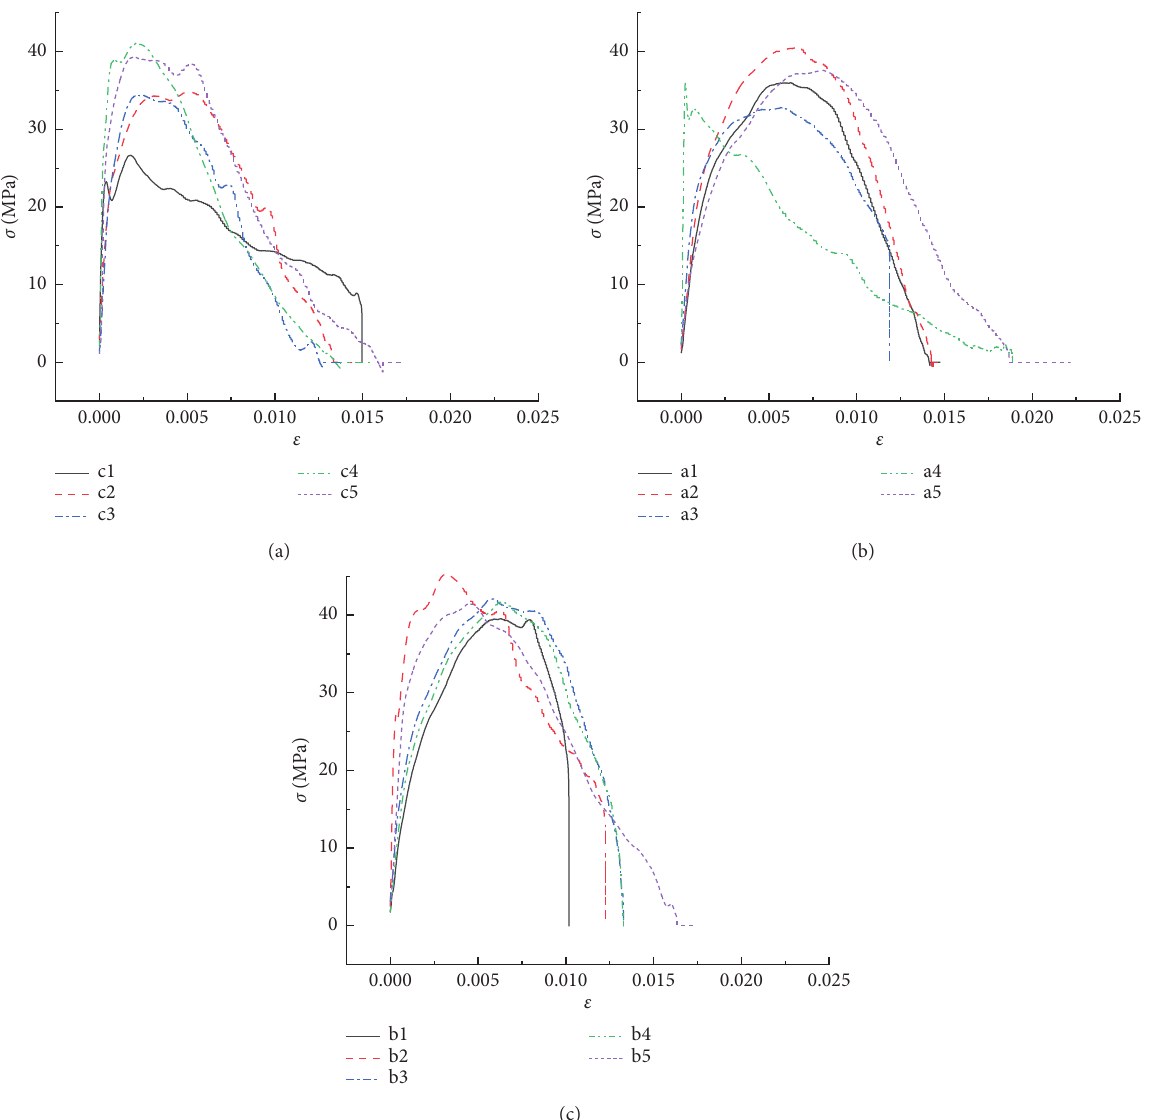
Figure 6: Stress-strain curves of specimens at different loading rates. (a) 0 ° . (b) 45 ° . (c) 90 °